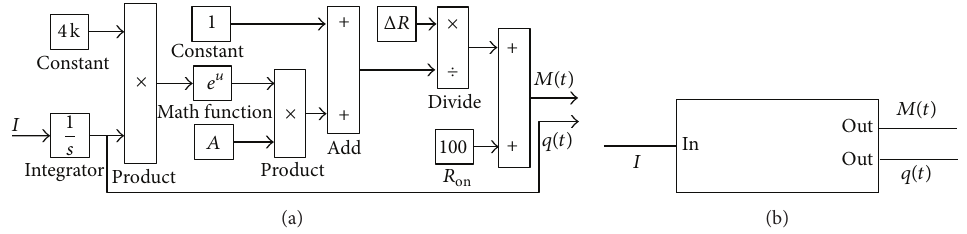
Figure 8: The simplified memristor model. (a) The simplified Simulink model of the memristor. (b) The package of the memristor.